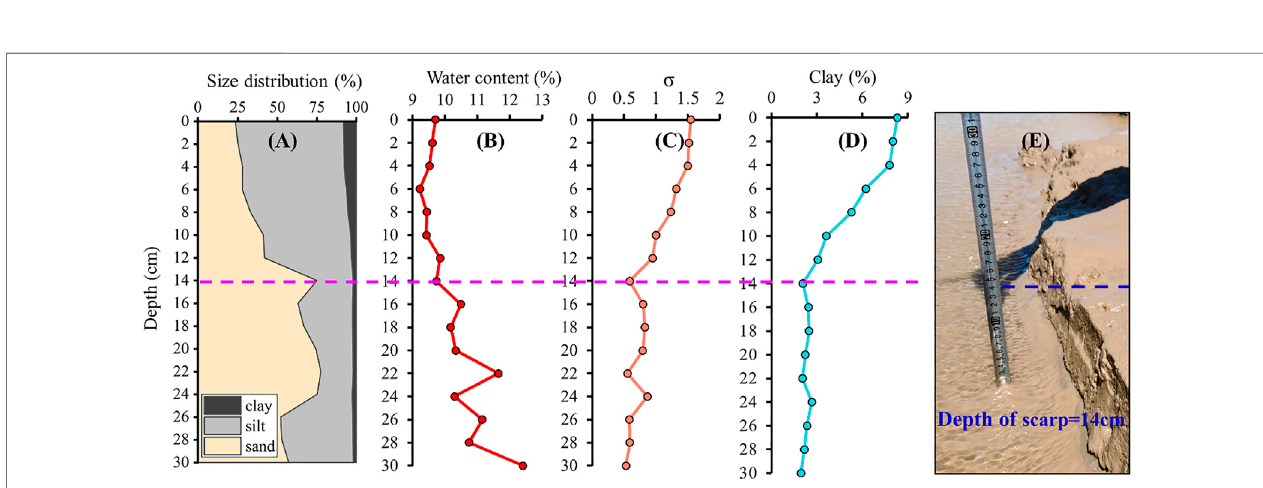
FIGURE 9 | Vertical pro fi les of sediment characteristics on hummocky patches, (A) grain size distribution of sediments, (B) water content, (C) sorting coef fi cient, (D) clay content, (E) fi eld photo of hummocky patches, photographed on 15th May, showing the depth of erosion patch is around 14 cm (blue dash line). The purple dash line shows the boundary between upper and lower layers with remarkable differences in sediment properties.